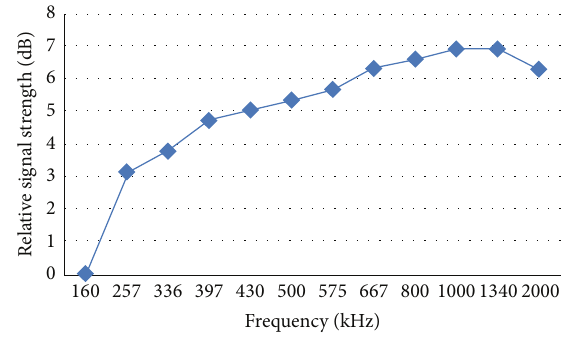
Figure 9: Relative signal strength versus frequency.